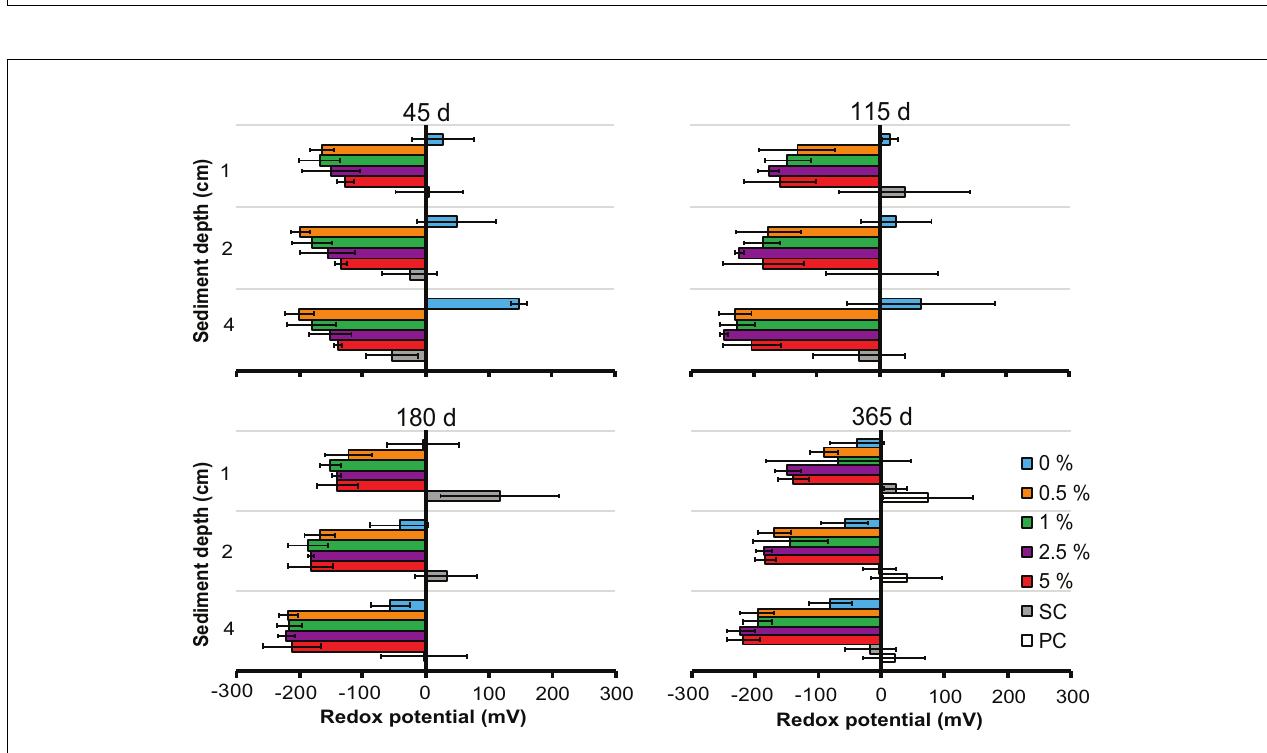
FIGURE 4 | Sediment redox potential (mV) in the different treatments over time. Errors bars denote ± 1 standard error of the mean ( n = 3). Colors used for the different treatments are the same as in Figure 2 to aid clarity.